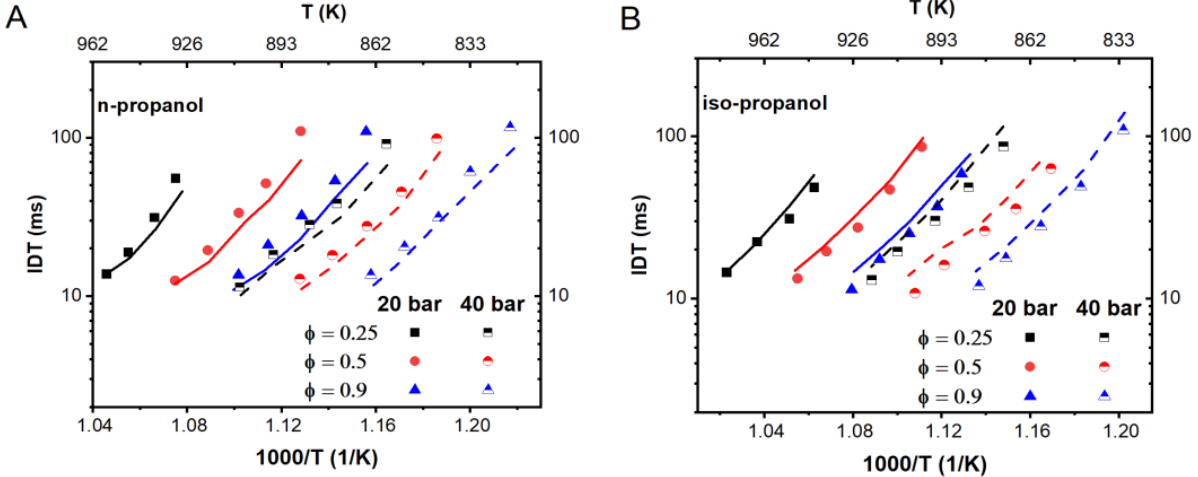
Figure 10. IDTs of ( A ) n-propanol and ( B ) iso-propanol measured in the RCM [39–41] at 20 and 40 bar and φ = 0.25, 0.5, and 0.9. (Symbols: experimental points; Lines: model predictions).